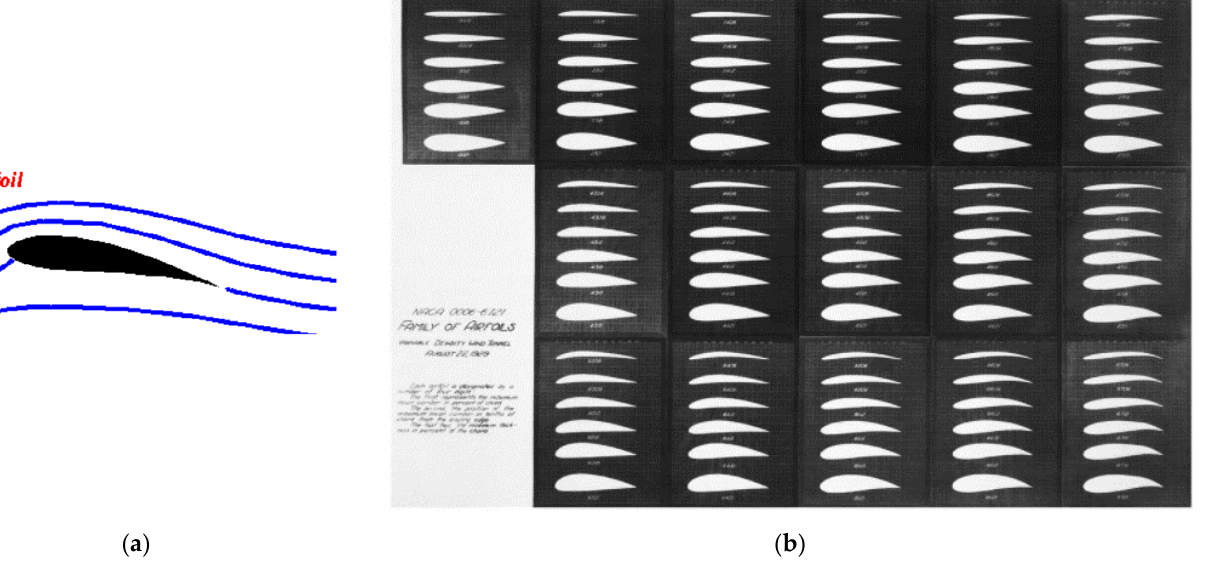
Figure 1. Airfoils: ( a ) streamlines over a typical airfoil [9]; ( b ) NACA 0006-6121 family of air foils [8].